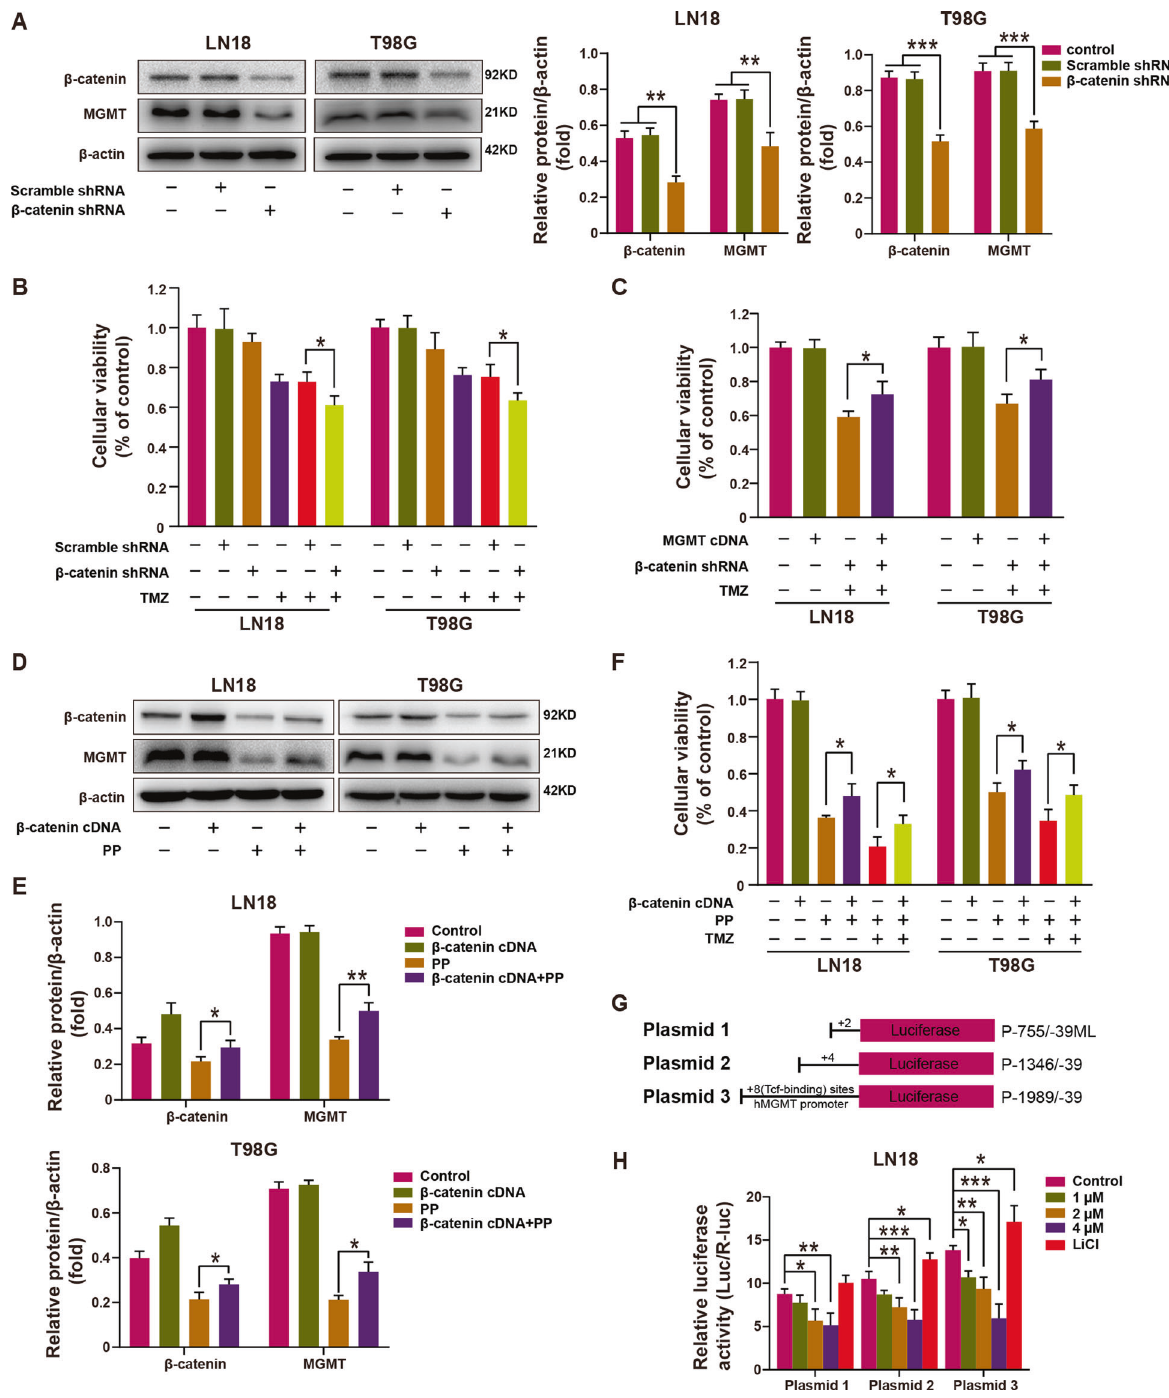
Fig. 5 PP-induced MGMT suppression and weakened-resistance to TMZ of GBM cells mediated by β -catenin. A MGMT and β -catenin protein levels in β -catenin knockdown and control cells were examined within LN18 and T98G cells (left panel). Densitometric analysis of β -catenin and MGMT expression (right panel) ( n = 3). B Cell viability in β -catenin knockdown and control cells under TMZ treatment within LN18 and T98G cells ( n = 3). C Effect of MGMT overexpression on cell viability in β -catenin knockdown and TMZ treatment groups within LN18 and T98G cells ( n = 3). D MGMT and β -catenin protein levels in β -catenin overexpression and control cells under PP treatment. E Densitometric analysis of β -catenin/ β -actin and MGMT/ β -actin expression relative fold change in LN18 (top panel) and T98G cells (bottom panel) ( n = 3). F Effect of β -catenin overexpression on cell viability under PP or PP combined TMZ treatment within LN18 and T98G cells ( n = 3). G Schematic diagram for the MGMT promoter luciferase reporter plasmids (P-755/ − 39 ML, P-1346/ − 39 ML, and P-1989/ − 39 ML) possessed desired candidate Tcf/Lef-binding site numbers. H MGMT promoter luciferase reporter activity was measured following PP treatment at different contents in LN18 cells ( n = 3). Data were presented in the manner of mean ± SD. * p < 0.05; ** p < 0.01; *** p < 0.005.